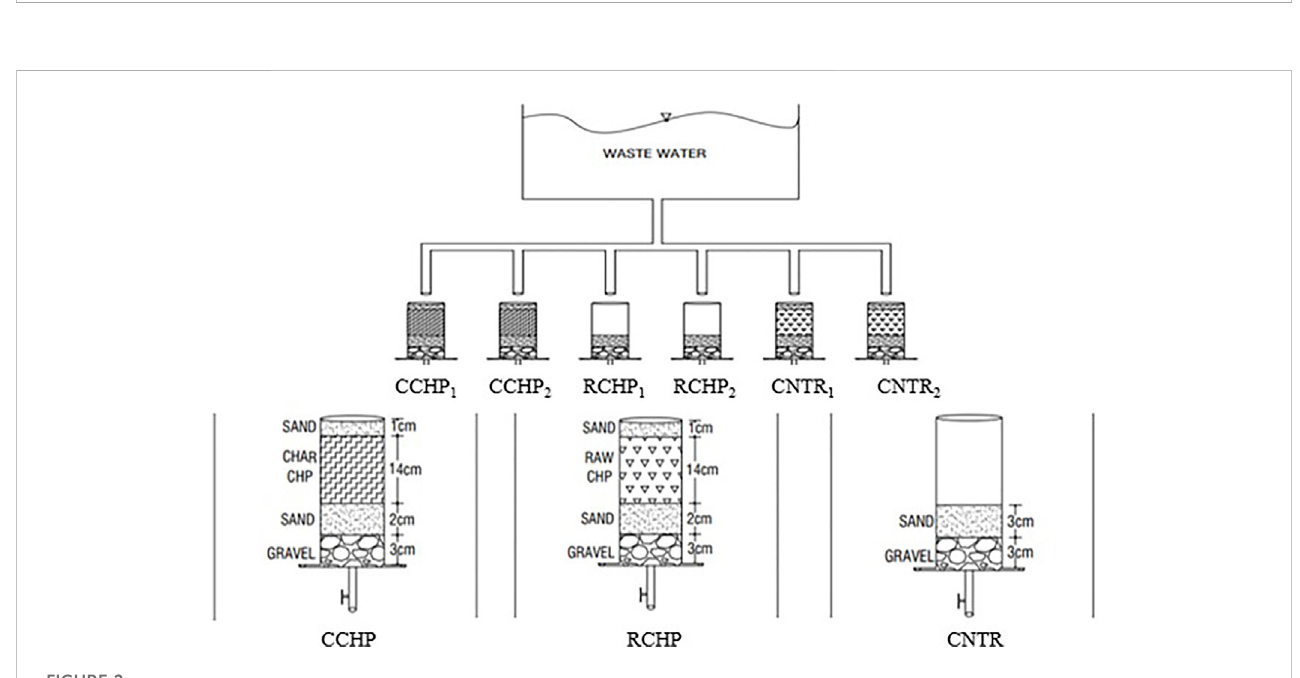
FIGURE 2 Schematic diagram of experimental Setup (not to